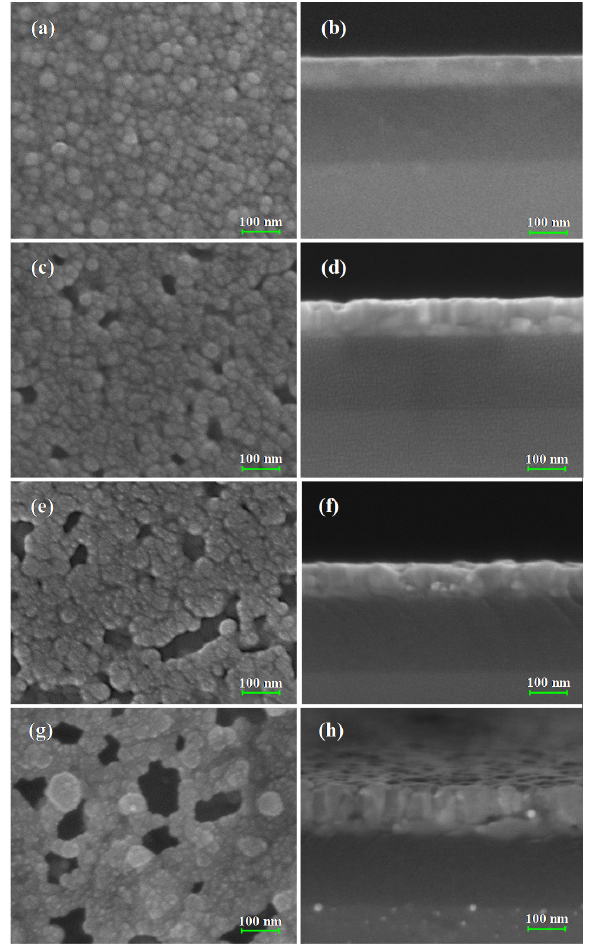
Figure 2. The SEM micrograph of ZnO films with different thicknesses of Ag: ( a ) top view, ( b ) side view of a 100 nm ZnO film without Ag; ( c ) top view, ( d ) side view of a 100 nm ZnO film with 1 nm of Ag; ( e ) top view, ( f ) side view of a 100 nm ZnO film with 3 nm of Ag; ( g ) top view, ( h ) side view of a 100 nm ZnO film with 5 nm of